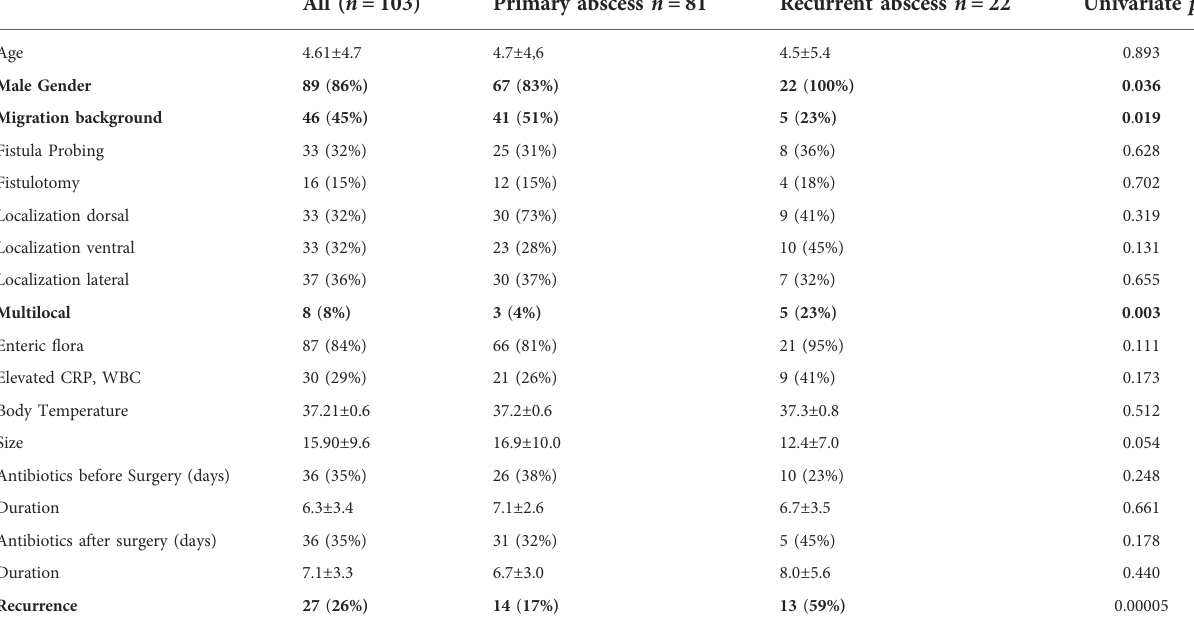
TABLE 2 Patient and disease characteristics according to type of abscess (primary vs.